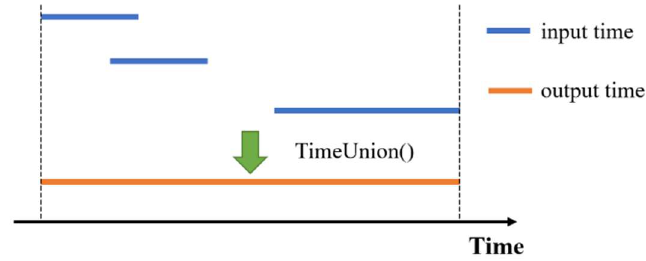
Figure 3. Schematic diagram of time element union operation.